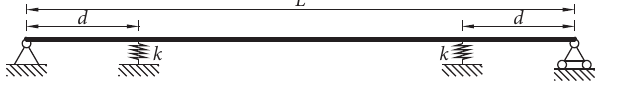
Figure 3: Simplified force diagram of cable influenced by stiffness of damper.